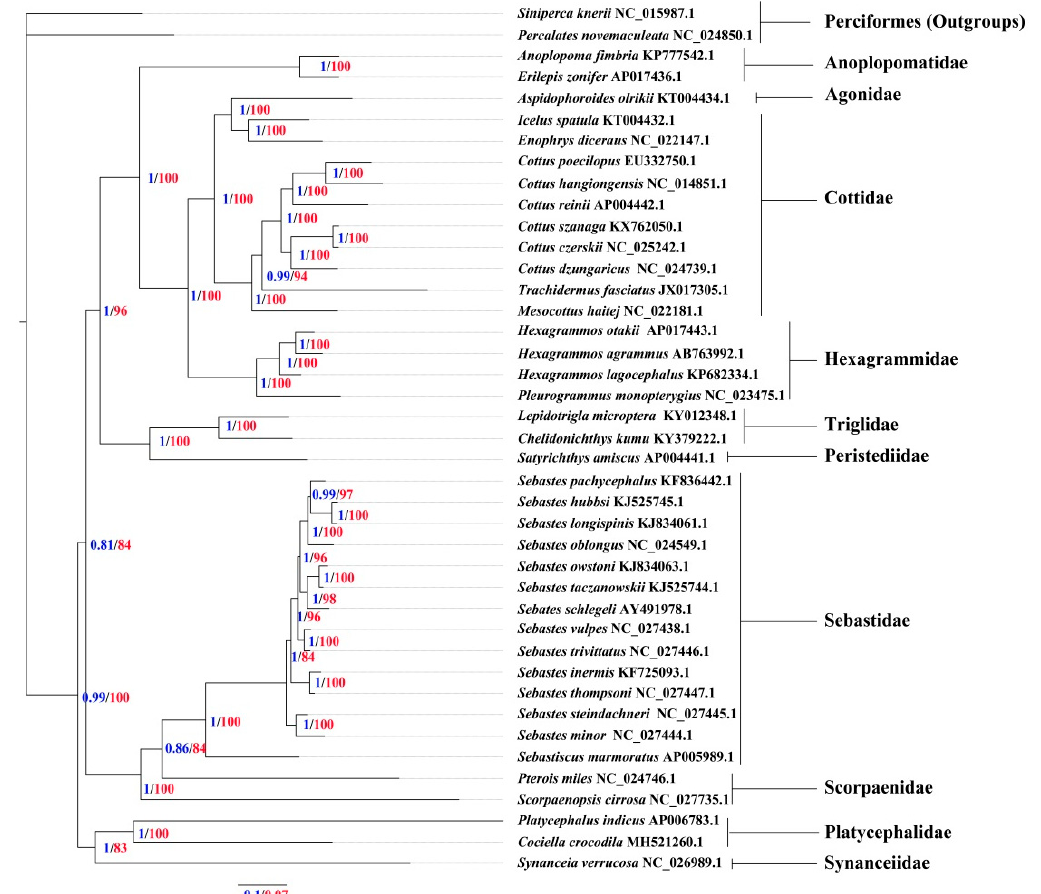
Figure 3. Phylogenetic tree based on the nucleotide sequences of the 13 PCGs, using Bayesian inference (BI) and maximum likelihood (ML) methods, among Scorpaeniformes species. Perciformes fishes ( P. novemaculeata (NC_024850.1) and S. knerii (NC_015987.1)) were used as outgroups. Numbers above the branches refer to Bayesian posterior probability values (blue numbers) and ML bootstrap values (red numbers).